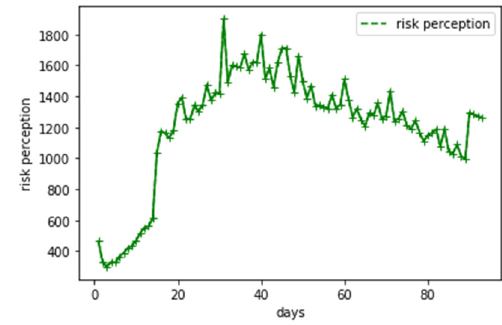
Figure 1. Time series of risk perception index. Table 3. Definition of